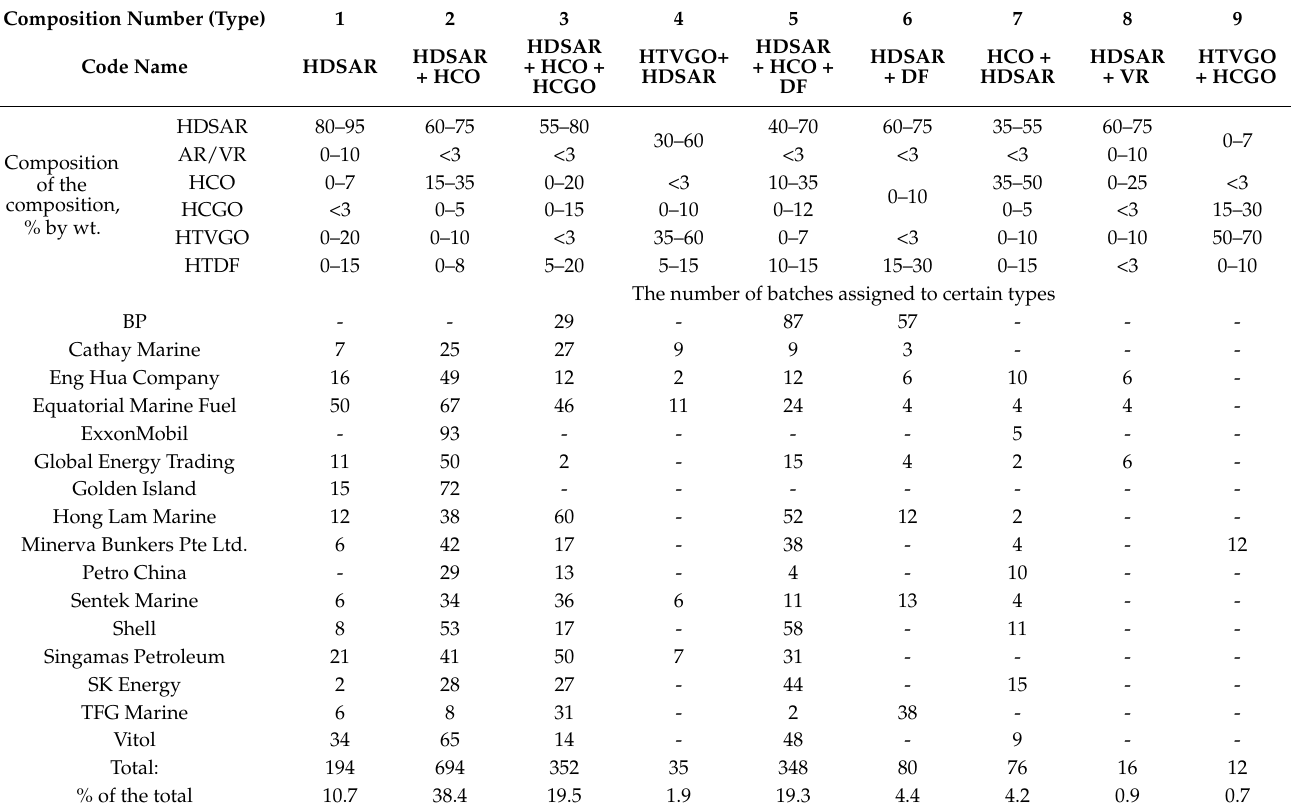
Table 7. Distribution of RMG 380 shipments in the port of Singapore by type